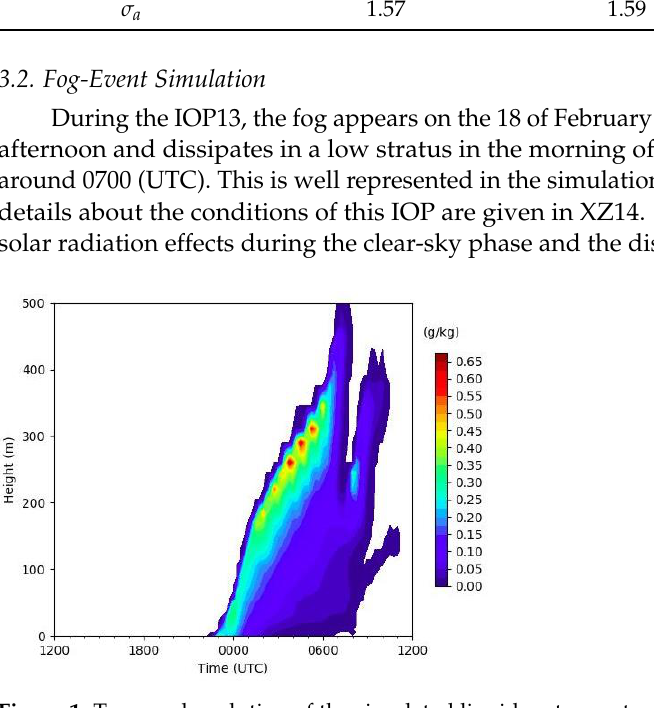
Figure 1. Temporal evolution of the simulated liquid water content in g kg − 1 with the solar scheme when surface parameters are deduced from